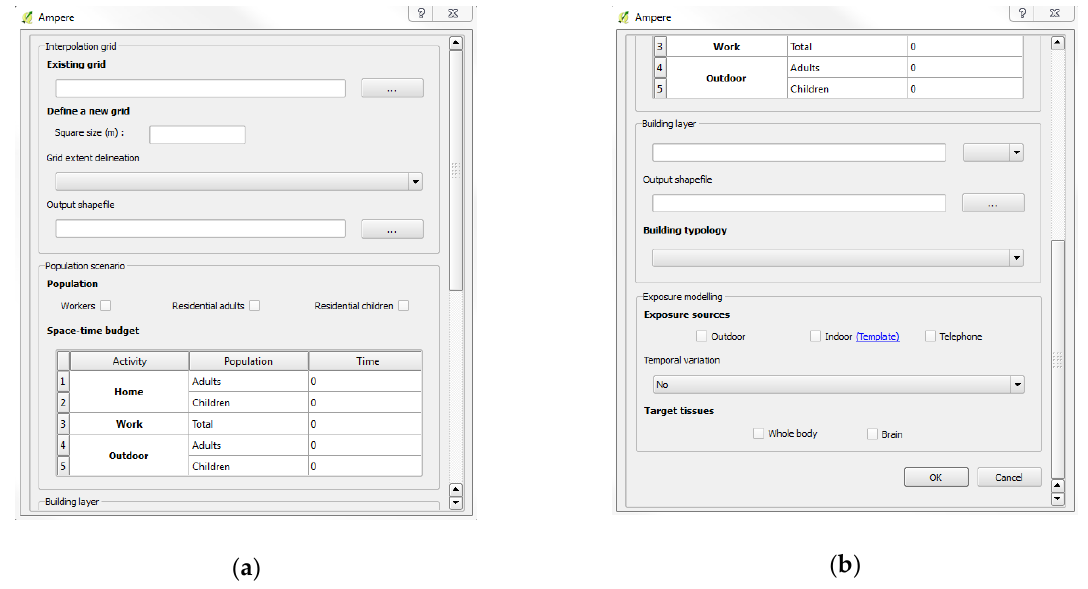
Figure 2. Screenshots of the graphical user interface (main toolbox) developed in the plugin: ( a ) Top of the main toolbox; ( b ) bottom of the main toolbox.